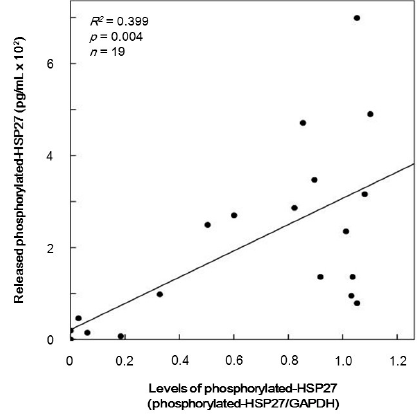
Figure 4. The relationship between individual levels of HSP27 phosphorylation (Ser-78) in the platelets and the release of phosphorylated-HSP27 levels induced by TRAP in type 2 DM patients. The baseline levels without stimulation were subtracted from each of the individual HSP27 phosphorylation levels, and the release of phosphorylated-HSP27 levels in the conditioned plasma after platelet aggregation stimulated by 10 µM of TRAP for 4 min were collected. Each of the data regarding the phosphorylation of HSP27 in platelets and the levels of release of phosphorylated-HSP27 were determined by a Western blot analysis using the ImageJ and enzyme-linked immunosorbent assay (ELISA), respectively. These data were plotted and analyzed by linear regression analysis.